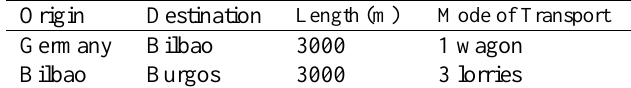
Table 5. Optimal so tion for the urgos demand